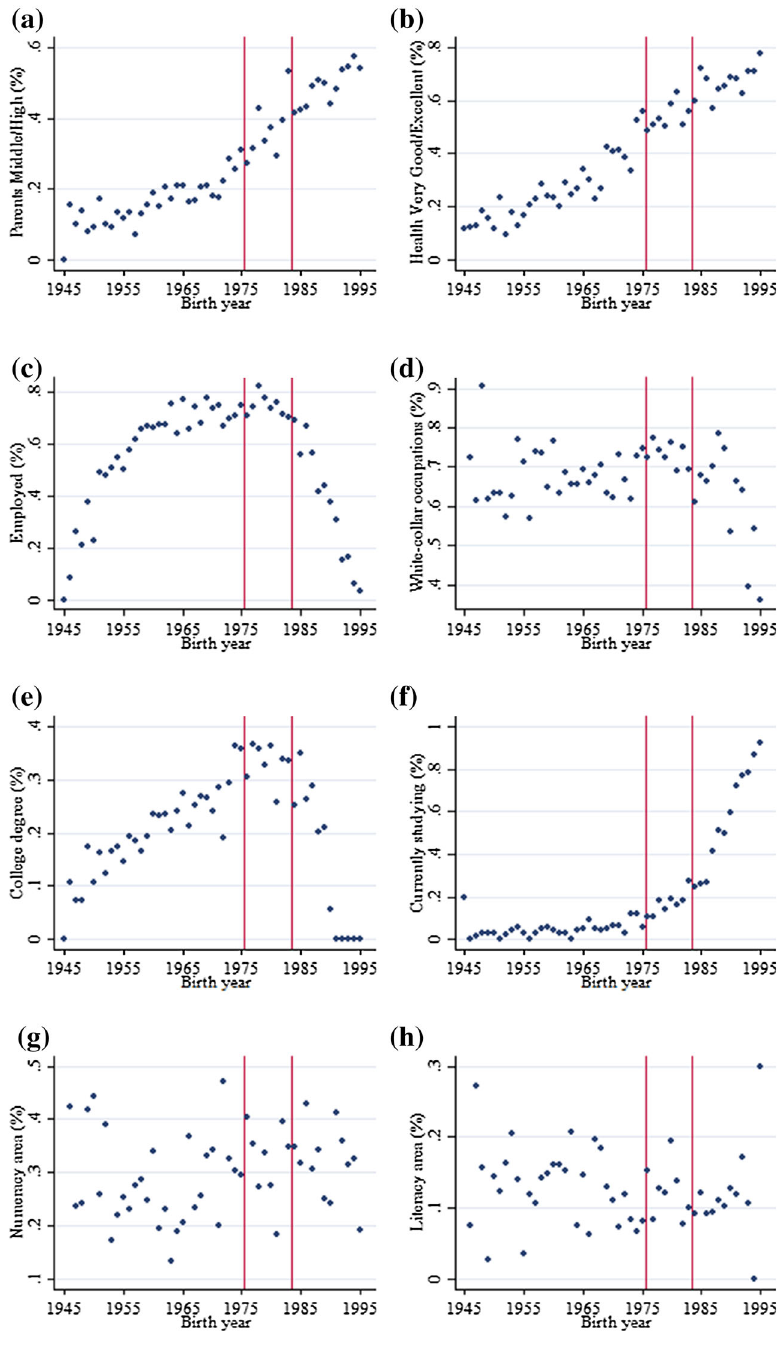
Fig. 4 Characteristics of the individuals by year of